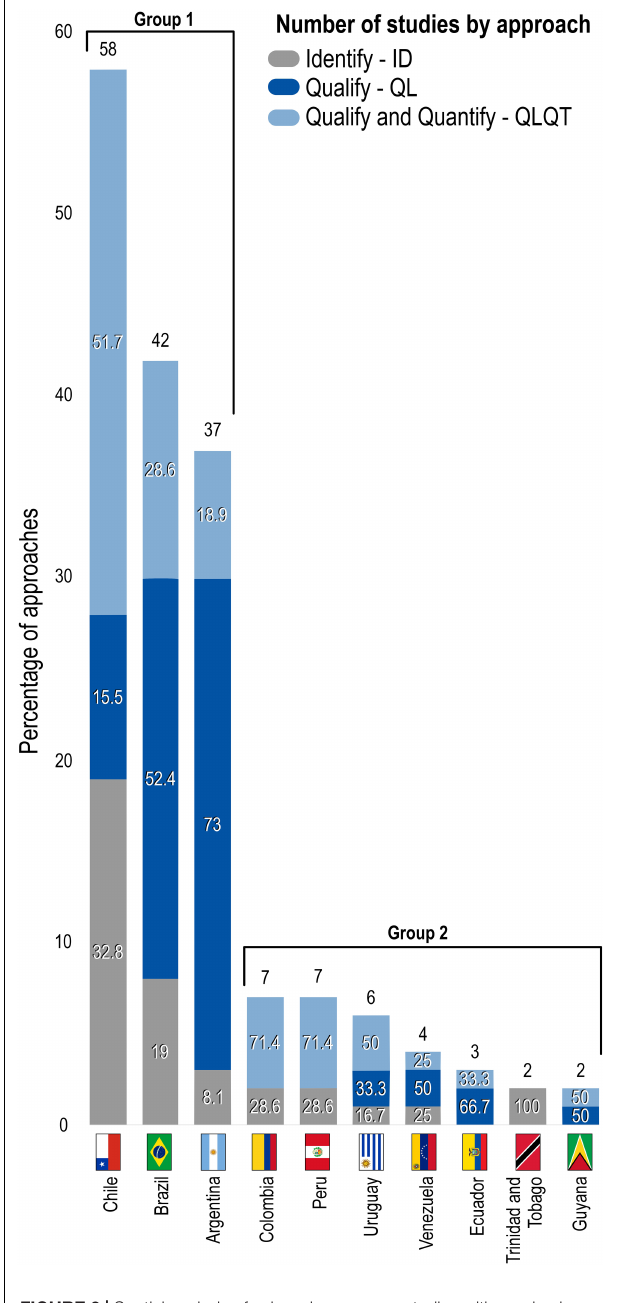
FIGURE 3 | Spatial analysis of submarine canyons studies with emphasis on the percentage of approach types concerning the ranking of publication by country and their division by